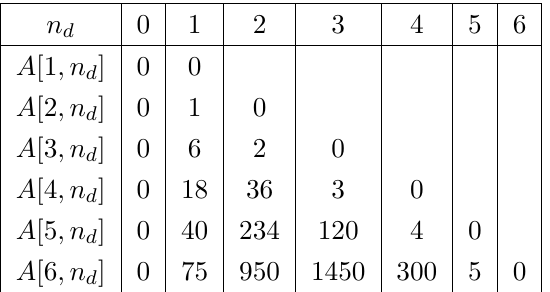
Table 2 . The number of ambiguities in the consistent solution of ghost correlators in 1- to 6-point functions. The level n d refers to the number of di(cid:11)erence operator insertions (any ghost-anti-ghost insertion counts as an average-di(cid:11)erence pair for this